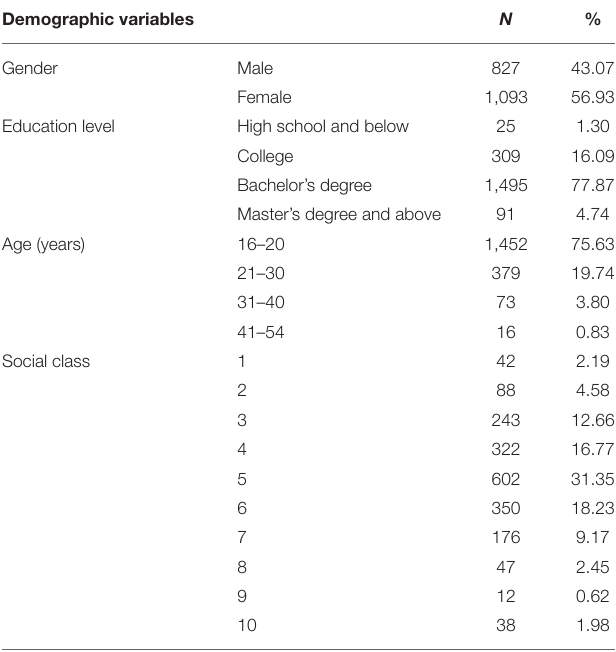
TABLE 1 | Demographic characteristics of the sample ( N = 1,920). Demographic